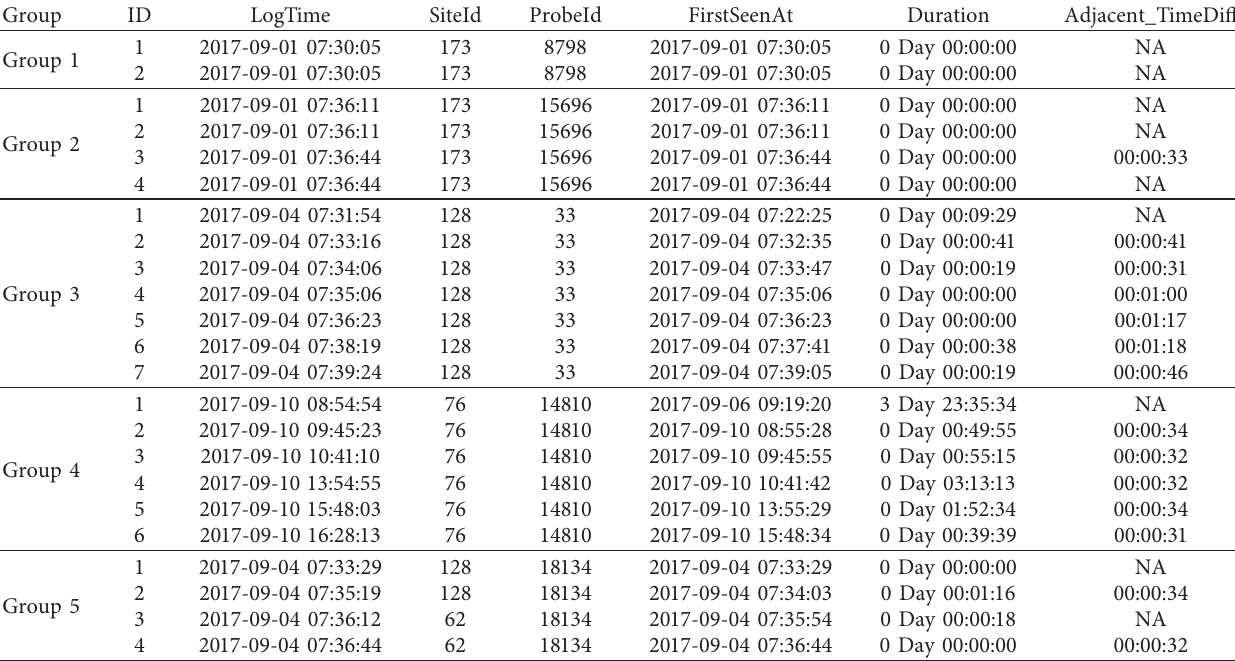
Table 1: A sample of collected BT time-stamped MAC address